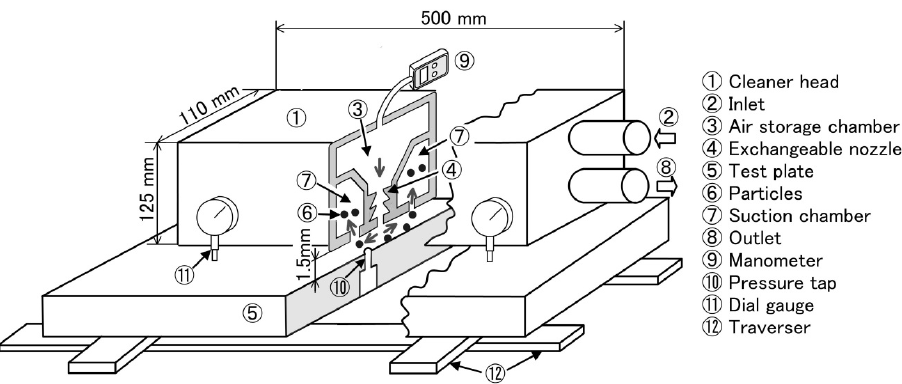
Fig. 1 Schematic of the experimental cleaning system using high speed impinging air jet to which high frequent pressure fluctuation is added by the cavity